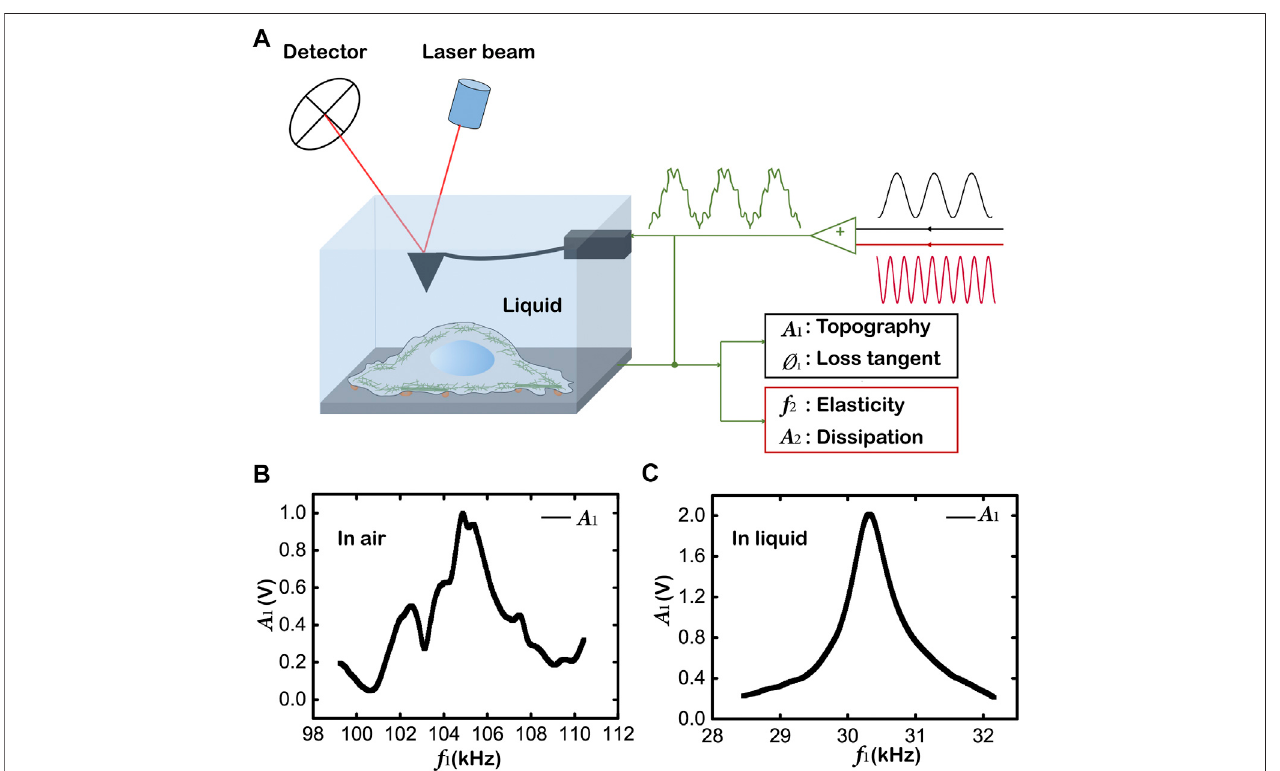
FIGURE 2 | Mapping topography and viscoelasticity of living cells by AM-FM AFM. (A) Schematics of the AM-FM AFM showing the experimental setup and the workingprinciple.TheAFMtipandthewholecantileverareimmersedintheliquid ofculturemediumfor insitu measurementoflivingcellsinphysiologicalcondition.Two separateexcitationsignalsarecombinedtoexcitethecantilever resonances.Thecantilever de fl ection whenprobingthesampleisanalyzed toevaluatetheoffsetsofthe two resonances for the mapping of topography and viscoelasticity. (B) The fi rst resonance signal of the cantilever without high damping in air. (C) The fi rst resonance signal of the cantilever in